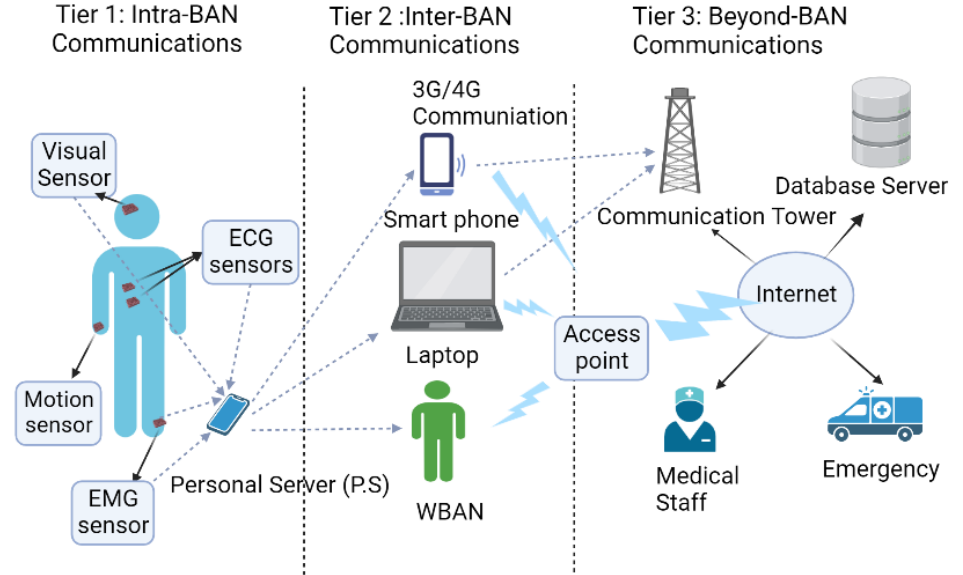
Figure 15. Tires of communication in